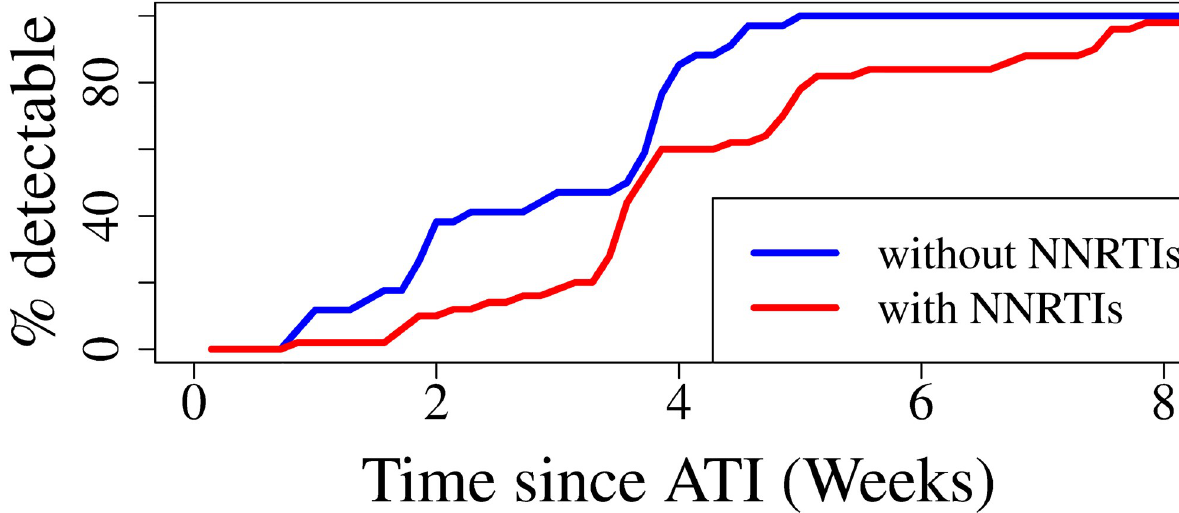
Fig 4. Time post-ATI of first detectable viral load measurement depending on study participant drug regimen, with or without NNRTIs. Note the statistically significant delay in viral rebound in participants taking NNRTIs pre-ATI (Wilcoxon rank sum test; p-value < 0.01).